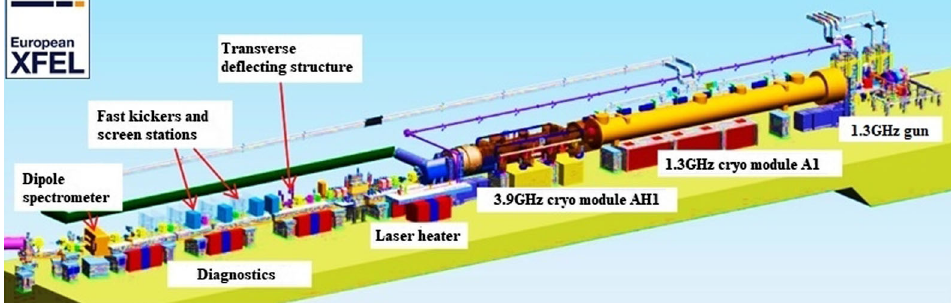
FIG. 1. A sketch of the injector section at the European XFEL. The longitudinal positions of main beam instrumentation devices used in this paper with respect to the cathode position at z ¼ 0 : the beam position monitor (BPM) 24 used in Fig. 5 is located at z ≈ 1 . 05 m; the toroid monitor (TORA) 25 used for charge measurements is placed at z ≈ 1 . 84 m; the BPM 25 as used in Fig. 6 is located at z ≈ 2 . 15 m; The transverse deflecting structure (TDS) applied for bunch length measurements is installed at z ≈ 29 . 8 m downstream the cathode.